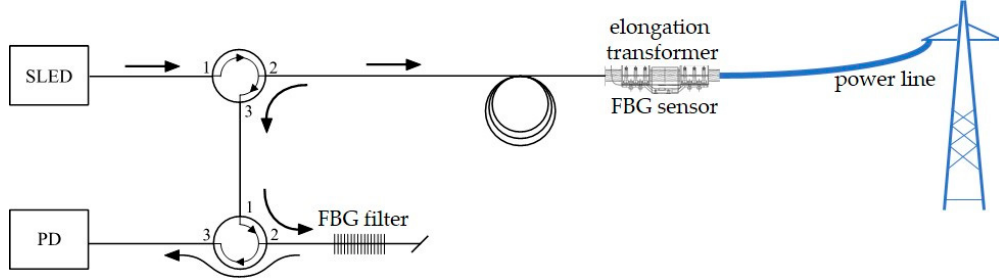
Figure 9. The final interrogation system for the overhead transmission line wire sag measurement. SLED: superluminescent light-emitting diode; PD: photodetector.